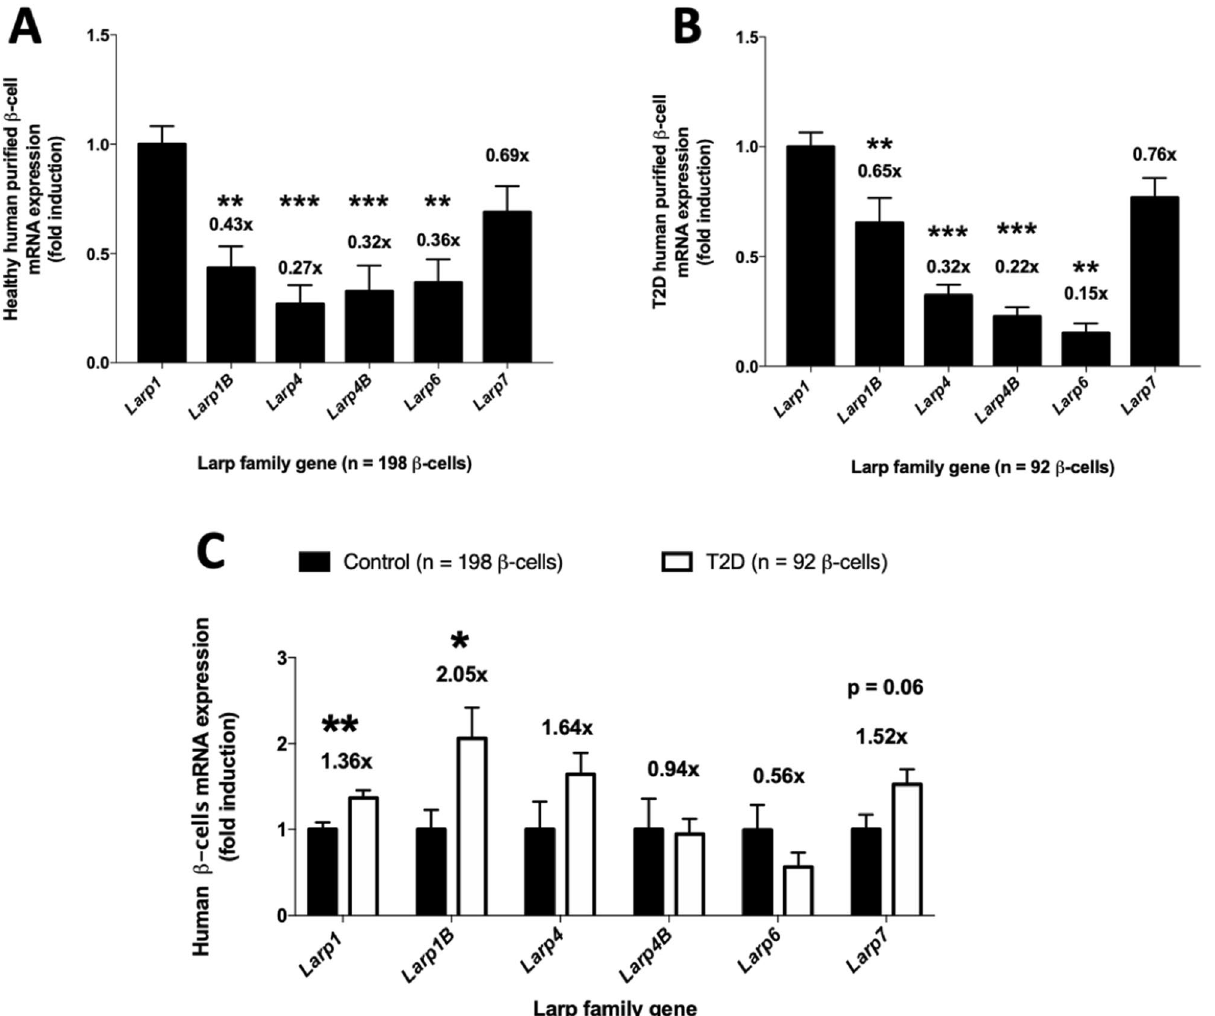
Figure 2. Diabetes increases Larp1 and Larp1B expression in human β-cells. ( A ) LARP family mRNA levels in human β-cells of healthy subjects. ( B ) Same as in A except that human β-cells from type 2 diabetic patients were used. **p < 0.01 and ***p < 0.001 compared to LARP1 mRNA levels assessed by one-way analysis of variance ( ANOVA ) followed by Dunnet’s posthoc test. ( C ) Fold induction of LARP family mRNA levels in β-cells from type 2 diabetes compared to healthy control subjects shown in ( A , B ). *p < 0.05 and **p < 0.01 compared to healthy subjects assessed by Student’s T test. Numbers on top of the bars denote fold induction. All data were obtained by analysis of single-cell transcriptome available by Segerstolpe et al . 30